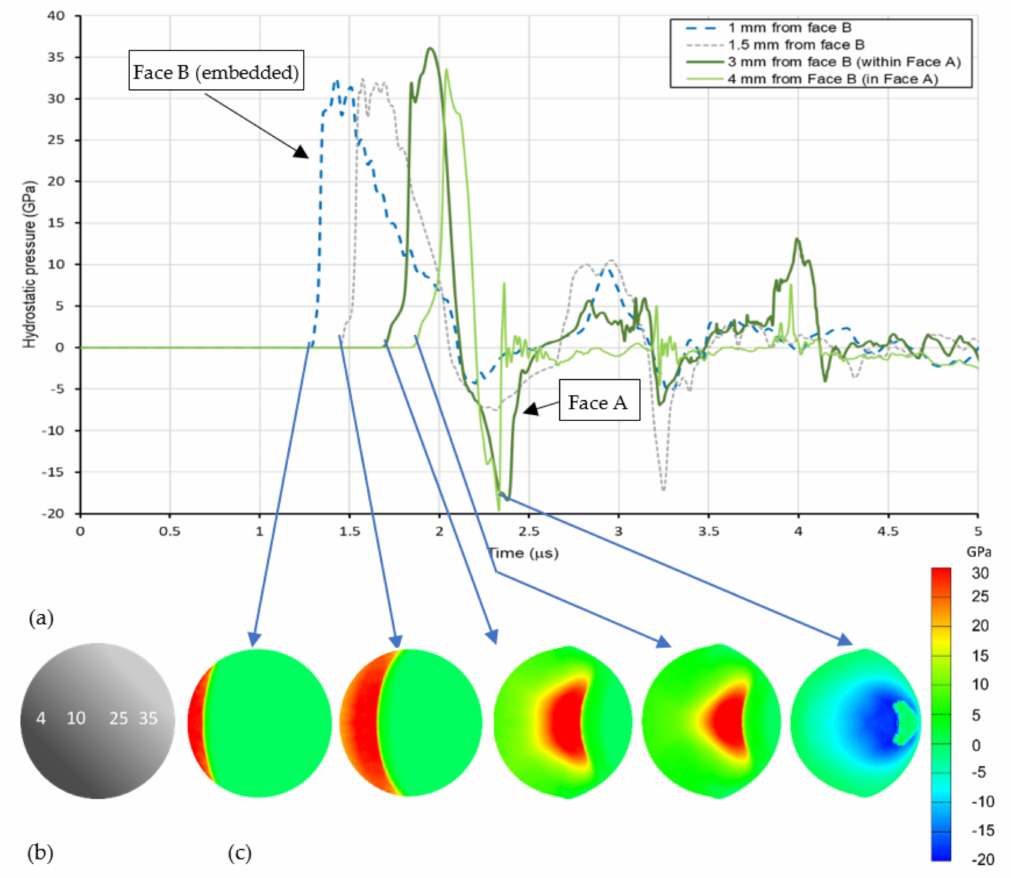
Figure 7. Simulated hydrostatic pressure development in a 5 mm ball bearing subjected to a 5.13 g charge. ( a ) Hydrostatic pressure history, where positive pressure indicates compression, ( b ) gauge locations on the ball bearing, ( c ) hydrostatic pressure contour plots at times after detonation that correspond to significant points in the hydrostatic pressure–time history (as indicated).